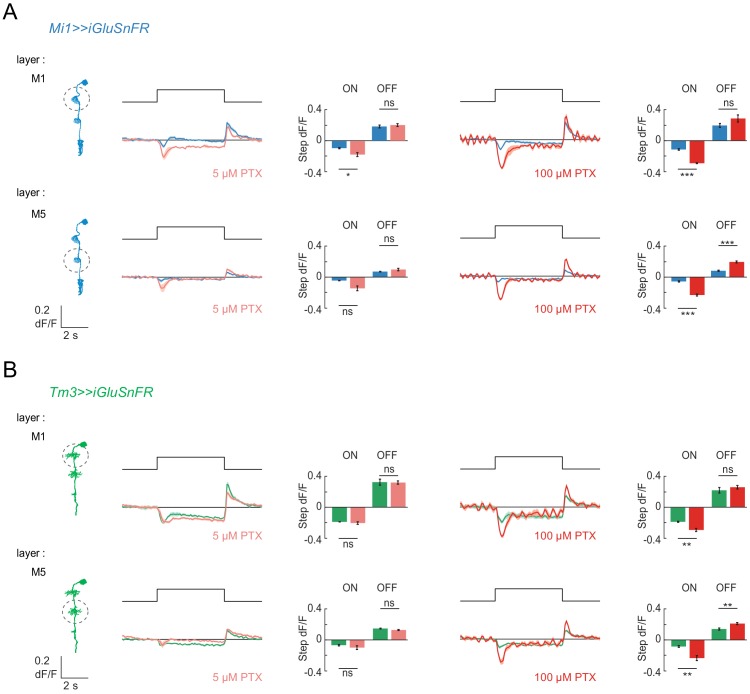
The glutamatergic input onto Mi1 and Tm3 dendrites is still present upon PTX application.(A,B) In vivo iGluSnFR signals recorded in layers M1 and M5 of Mi1 (A) or Tm3 (B) neurons, before (blue) and after application of either 5 or 100 µM PTX (light red/red). Bar plots showing the quantification of the ON and OFF response. **p<0.01, ***p<0.001, tested with paired Student t test. Sample sizes were N = 5 (64/67) for Mi1 in 5 µM PTX, N = 6 (72/72) for Mi1 in 100 µM PTX, N = 5 (62/60) for Tm3 in 5 µM PTX, and N = 5 (60/63) for Tm3 in 100 µM PTX, given as N = number of flies (number of cells in M1/M5). All traces show mean ± SEM.10.7554/eLife.49373.010Figure 2—figure supplement 3—source data 1.Table 1 contains all mean ± s.e.m.Data related to quantifications shown in main Figure 2—figure supplement 3, sorted by genotype and experimental condition.